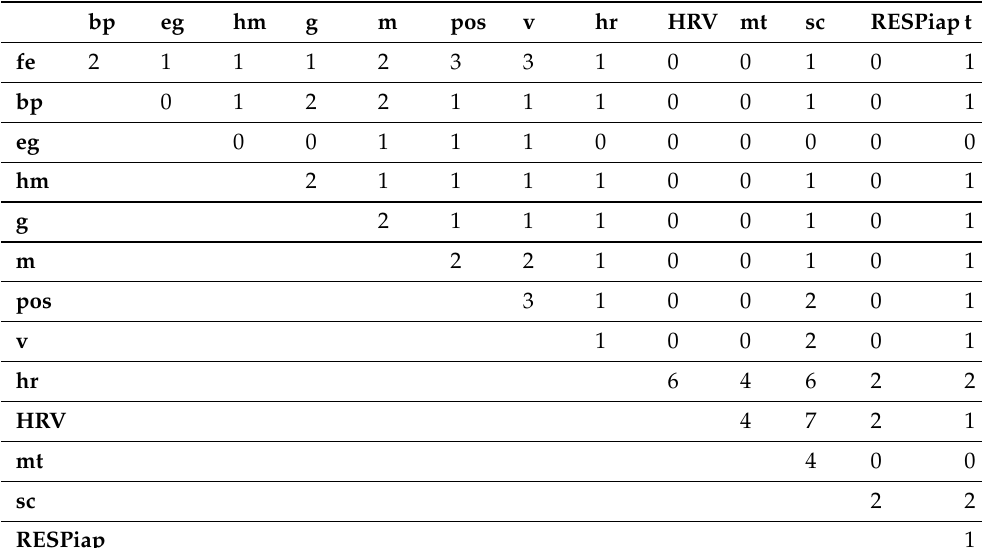
3. The following abbreviations are used: facial expressions—fe, body posture—bp, eye gaze—eg, head movement— hm, gestures—g, motion—m, the prosody of speech—pos, vocalization—v, heart rate—hr, muscle tension—mt,